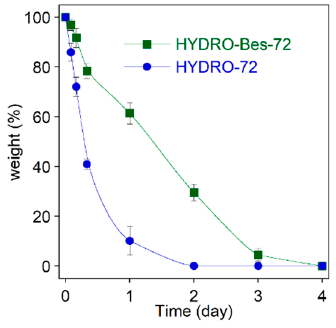
Figure 7. HYDRO-72 and HYDRO-Bes-72 degradation by hyaluronidase in PBS at 37 °C.